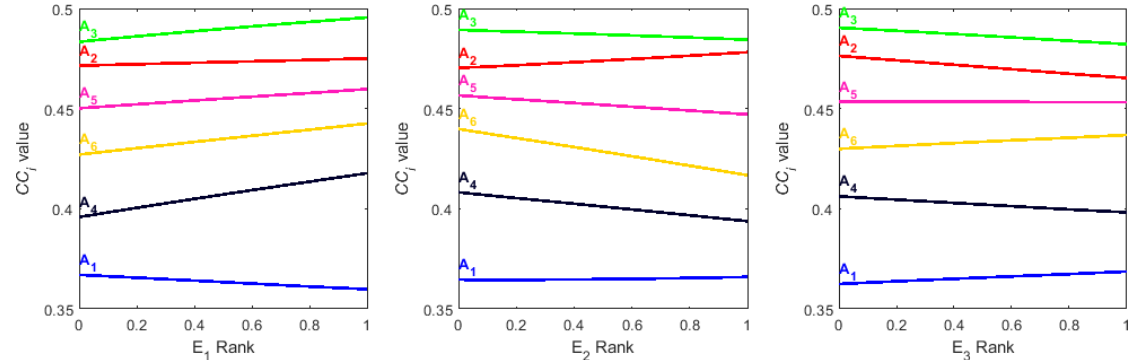
Figure 6. Closeness coefficient values depending on the rank of experts ( 𝛽 = 0.5 ).